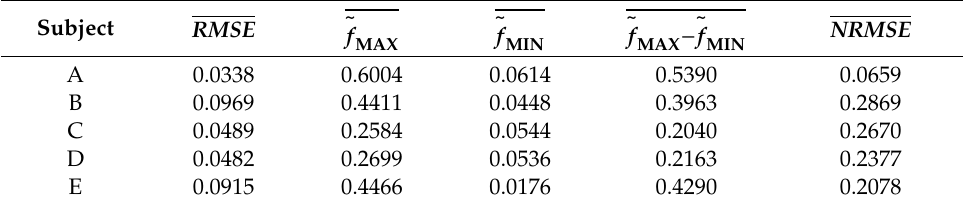
Table 4. Average precision error and maximum and minimum for each subject. Here, the precision errors RMSE k of subjects A through E determined using Equation (6) are shown, along with the maximum estimated value 𝑓̃ 𝑘MAX , the minimum estimated value 𝑓̃ 𝑘MIN , the difference between 𝑓̃ 𝑘MAX and 𝑓̃ 𝑘MIN (i.e., the estimated width), and the average of the cross-validation results over six runs for the calculated results for the precision evaluation index 𝑁𝑅𝑀𝑆𝐸 𝑘 defined in Equation (5).